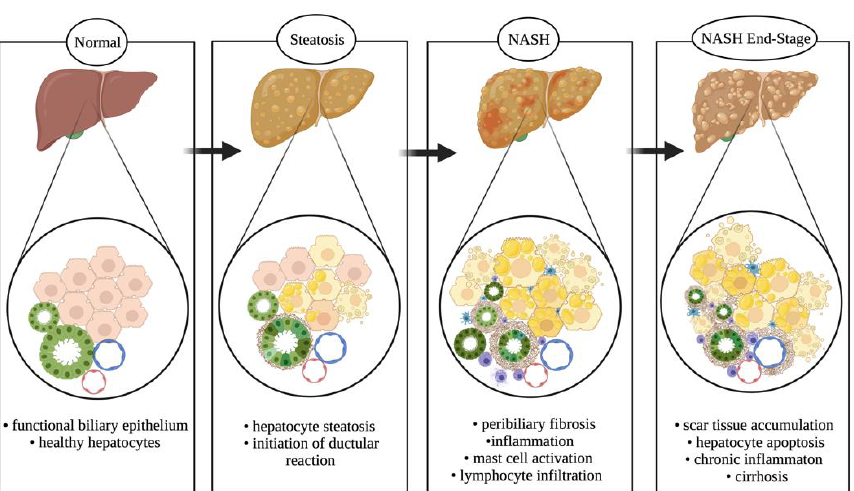
Figure 4. NAFLD spectrum. NAFLD progresses from a healthy liver parenchyma (steatosis < 5% of hepatocytes) to a stage (steatosis >5% of hepatocytes) with initiation of ductular reaction, mast cells and macrophage infiltration, and peribiliary fibrosis coupled with biliary senescence. It progresses further to a severe stage of NASH with scar tissue accumulation, elevated steatosis and hepatic ballooning, and increased circulating cytokine and SASP secretion from senescent bile ducts. Upon persistent dietary conditions, it assumes a chronic phenotype resulting in hepatocellular carcinoma and cirrhosis. Image made with BioRender (https://biorender.com/).